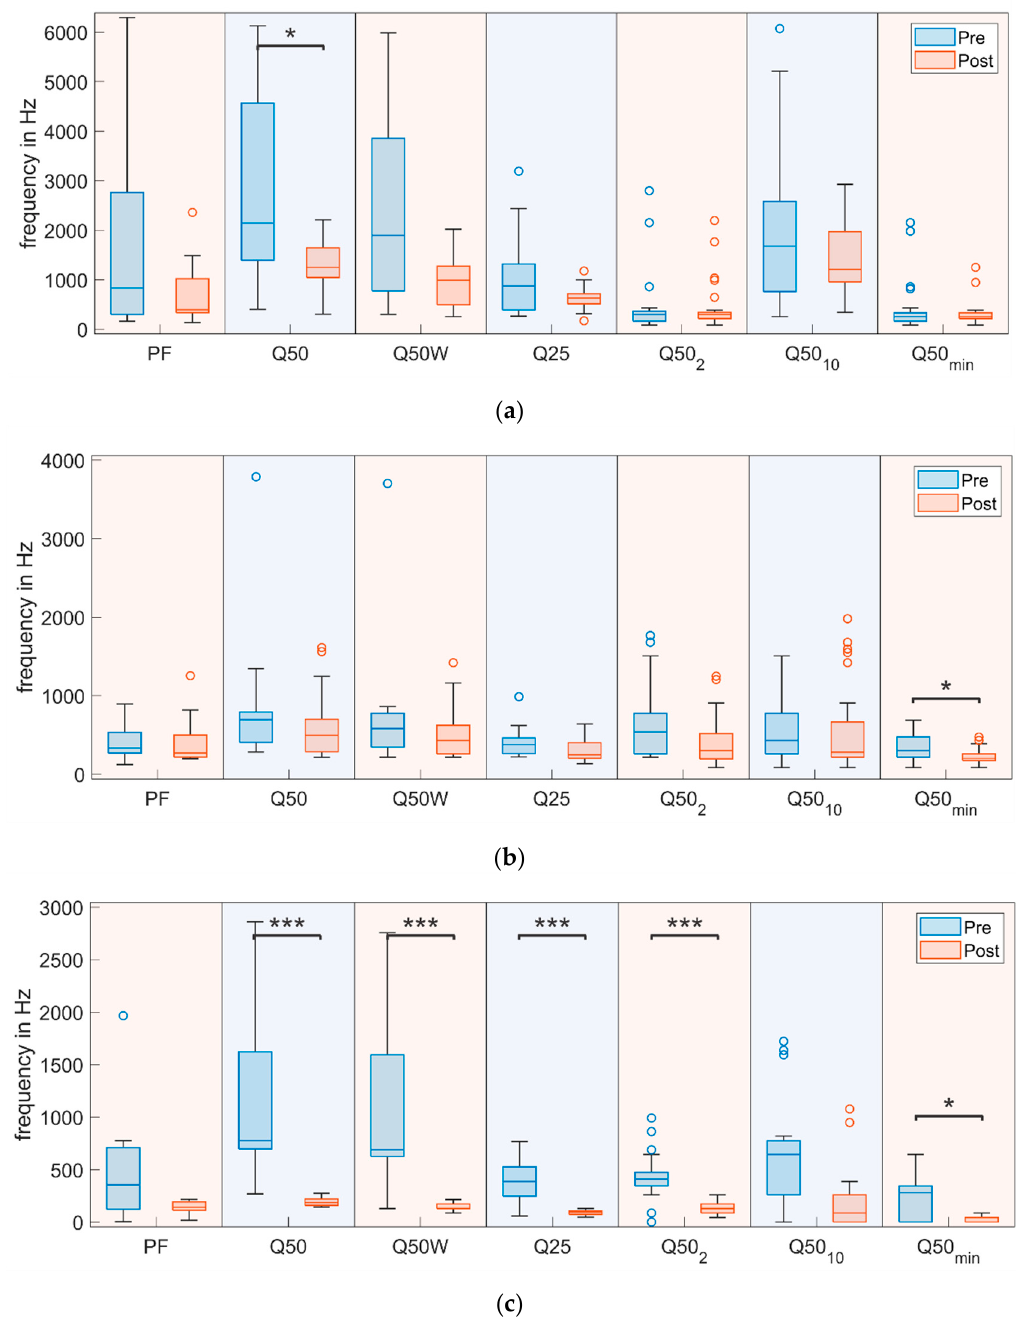
Figure 4. Boxplots of frequency-based parameters for ( a ) pig 1, ( b ) pig 2, and ( c ) pig 3 for pre- and post-surgery recordings. Statistically significant changes are marked with * symbols. (* p ≤ 0.05, *** p ≤ 0.001).